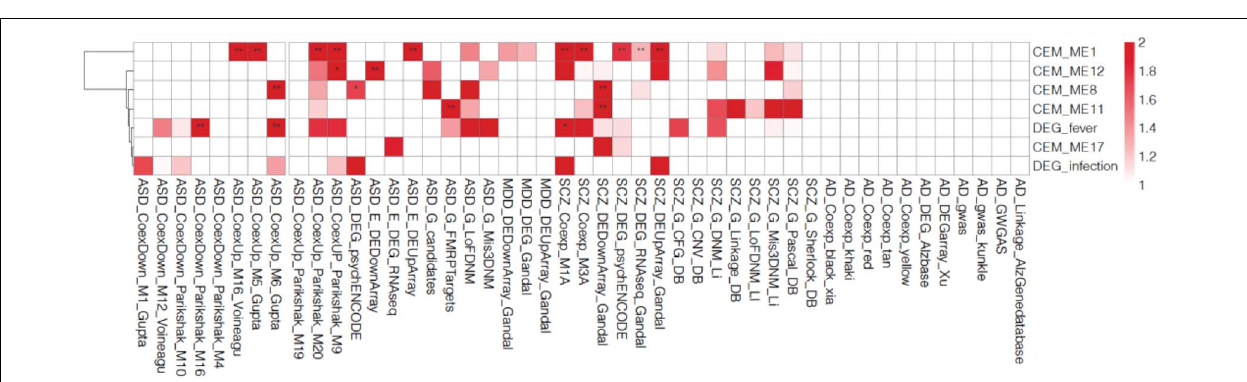
FIGURE 6 | Gene enrichment analysis of the co-expressed module (CEM) genes and differentially expressed genes (DEGs) by psychiatric disorders type. We found that the schizophrenia (SCZ) and autism spectrum disorder (ASD) candidate genes previously identified in other studies are enriched in agonal-related